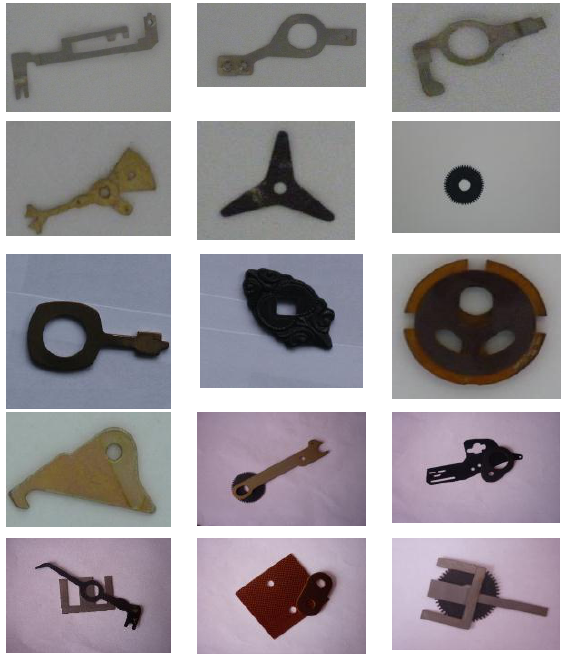
Figure 1. Examples of individual and superimposed flat